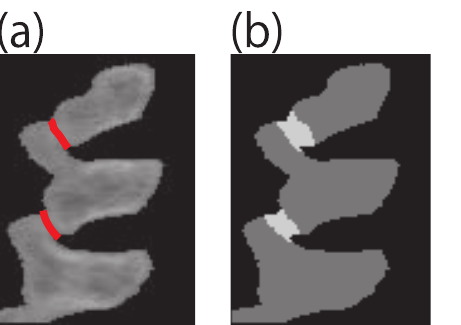
Figure 7. Expanding to multi segmentation. (a) is Interference regions and (b) is ROIs. In (a), red lines are the interference regions. In (b), two ROIs are shown in white.